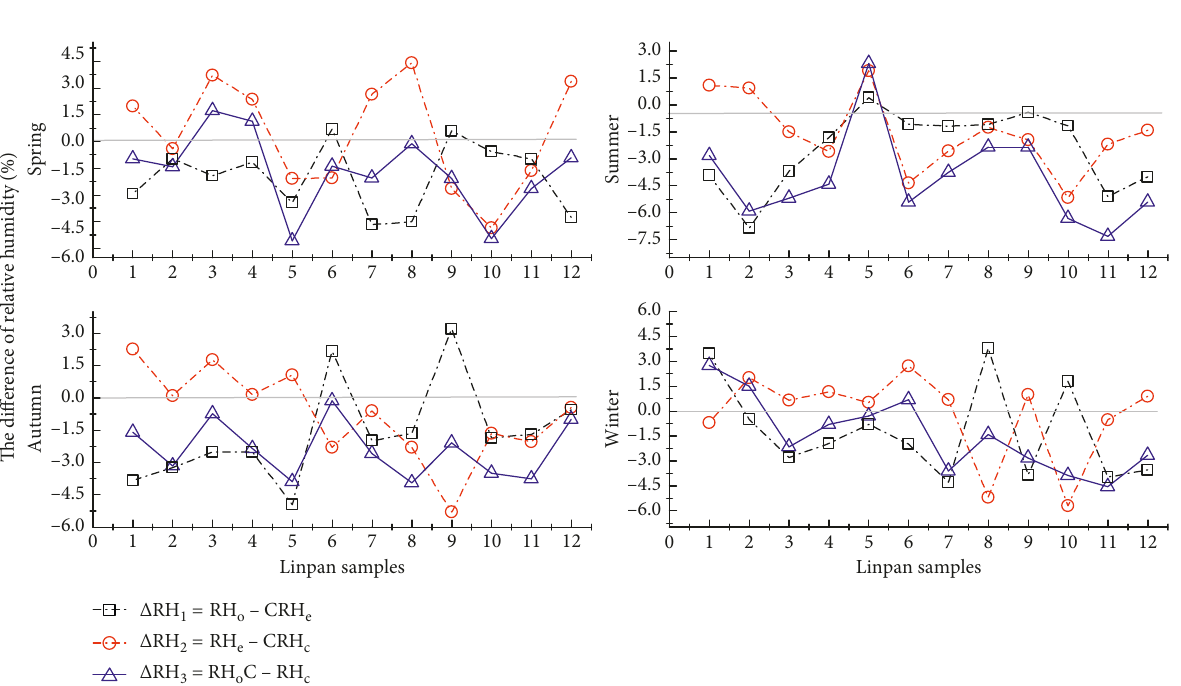
Figure 7: The seasonal solar radiation of Linpan